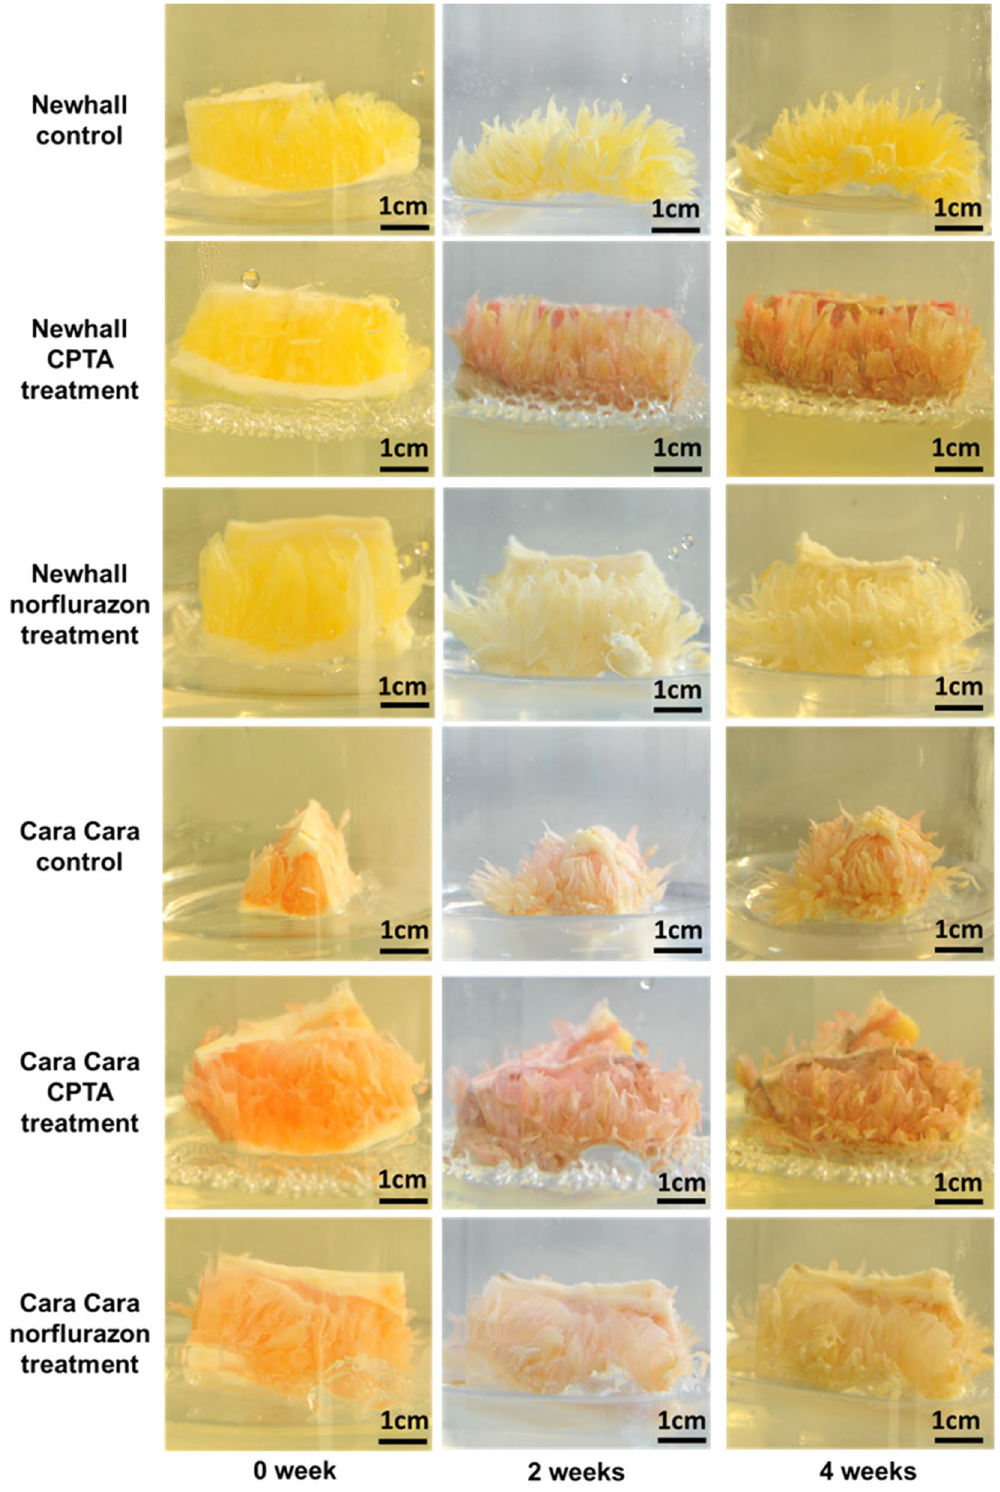
Figure 9. In vitro cultured flesh tissues of Newhall and Cara Cara following CPTA and norflurazon treatments. The 0 week tissues were separated from fruit at the S5 stage. CPTA, 2-(4-chlorophenylthio)-triethylamine